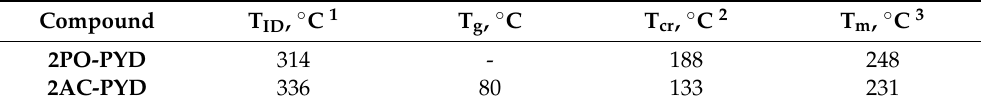
Table 1. Thermal characteristics of the